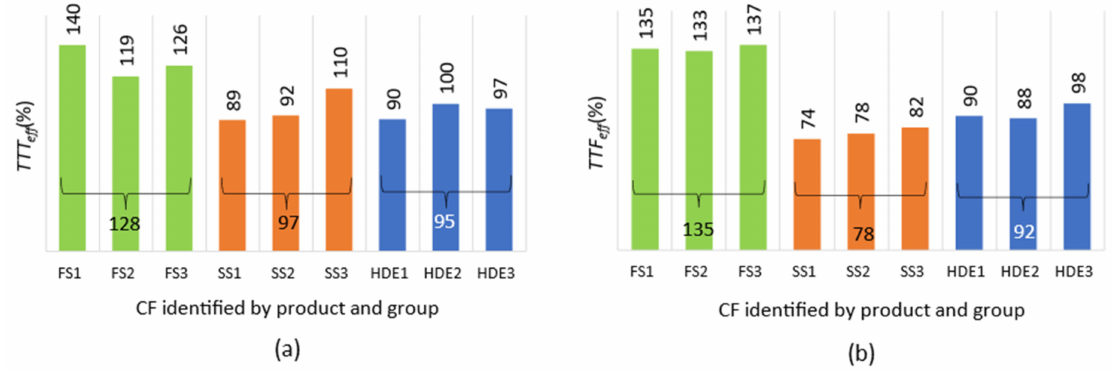
Figure 8. TTT eff ( a ) and TTF eff ( b ) obtained for each CF product with each group identified.